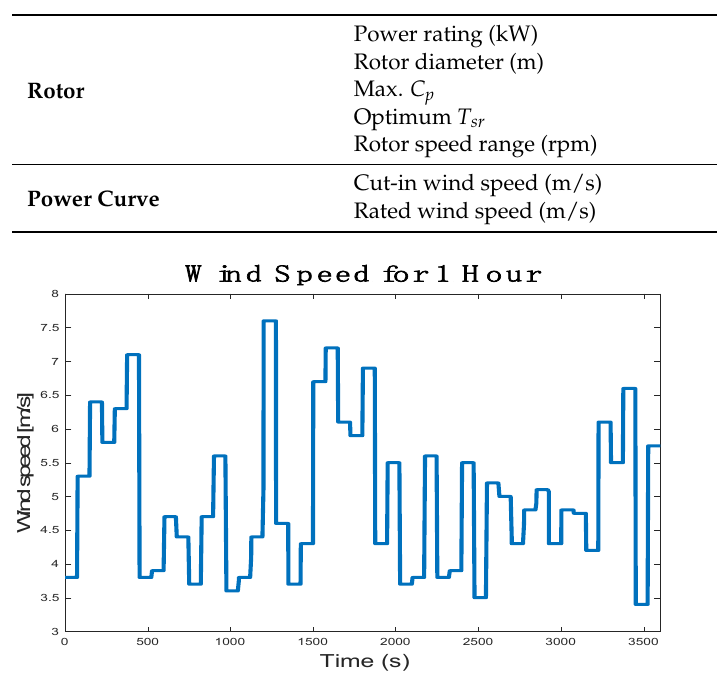
Figure 4. A series of wind speed step changes in one hour.